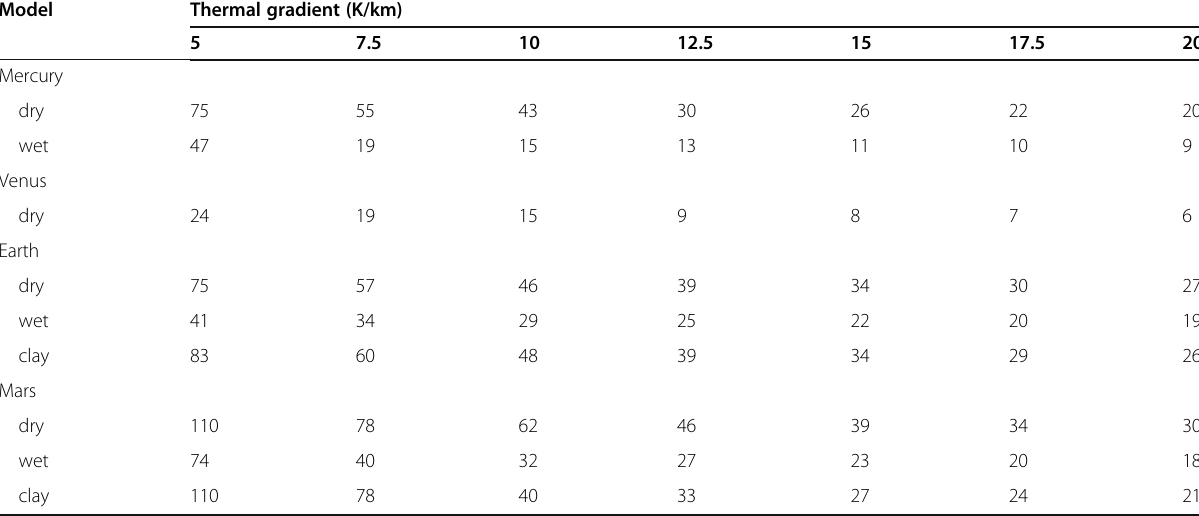
Table 4 Brittle – ductile transition (km) calculated using strain-rate of 10 -17 s -1